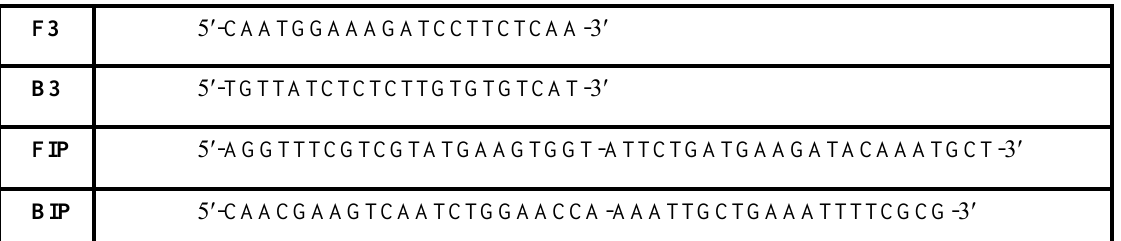
Table 1. The nucleotide sequence of primers targeting the alpha-INT1 gene of Candida albicans used in the LAMP reaction [10].